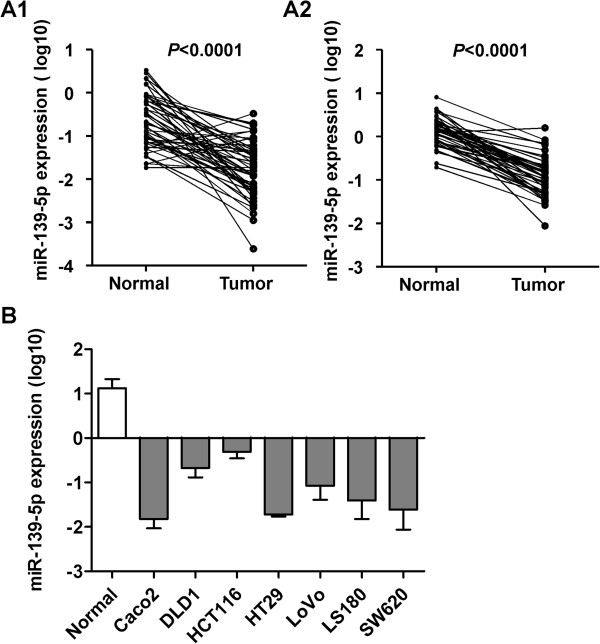
miR-139-5p was down-regulated in primary colorectal cancer tissues and colon cancer cell lines. (A) Levels of miR-139-5p in primary colorectal tumors compared with their adjacent normal tissues (A1, Cohort 1, n = 45; A2, Cohort 2, n = 50). (B) The expression level of miR-139-5p in seven colon cancer cell lines and normal colorectal tissues (n = 9) by qRT-PCR.